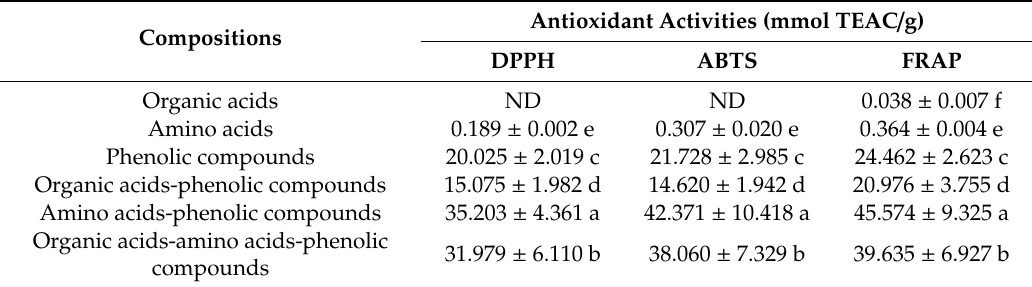
Table 5. E ff ect of main components on antioxidant activities of phenolic compounds in ZAV-5 1,2,3